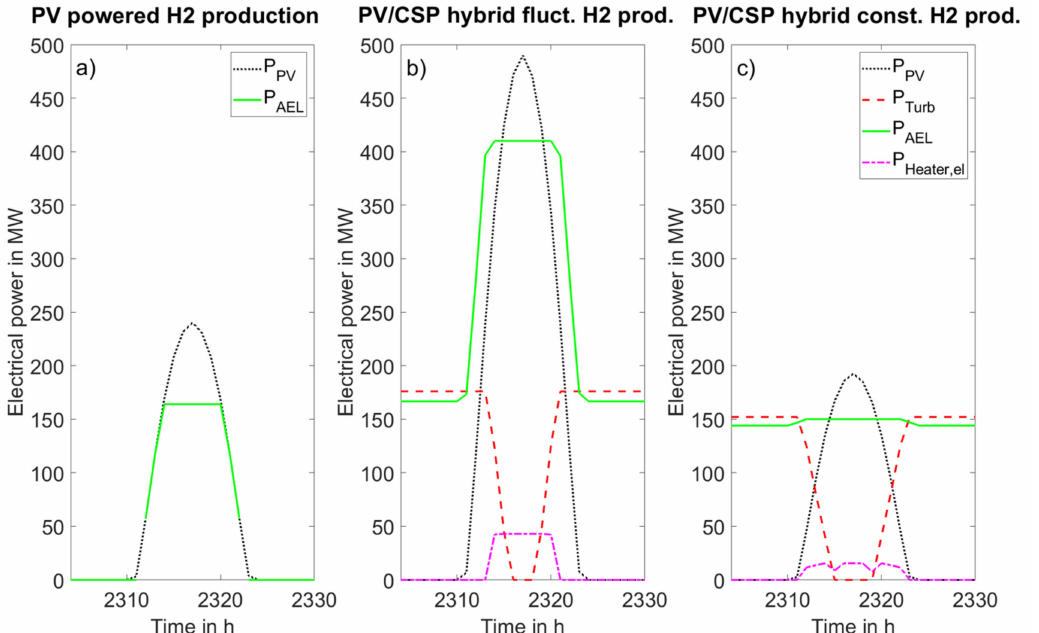
Figure 5. Comparison of different solar hydrogen plant operational concepts for a day with good solar irradiation. Results from the standard cost scenario for the location Ouarzazate, Morocco. ( a ) PV powered H2 production; ( b ) PV/CSP powered fluctuating H2 production; ( c ) PV/CSP powered constant H2